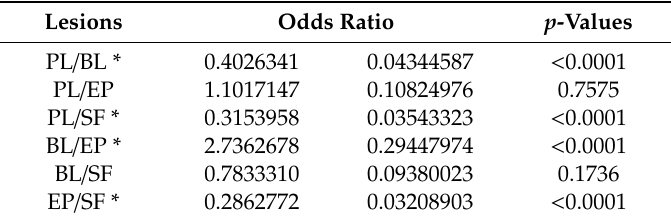
Table 2. Comparison of the detection rates of the different lesions.